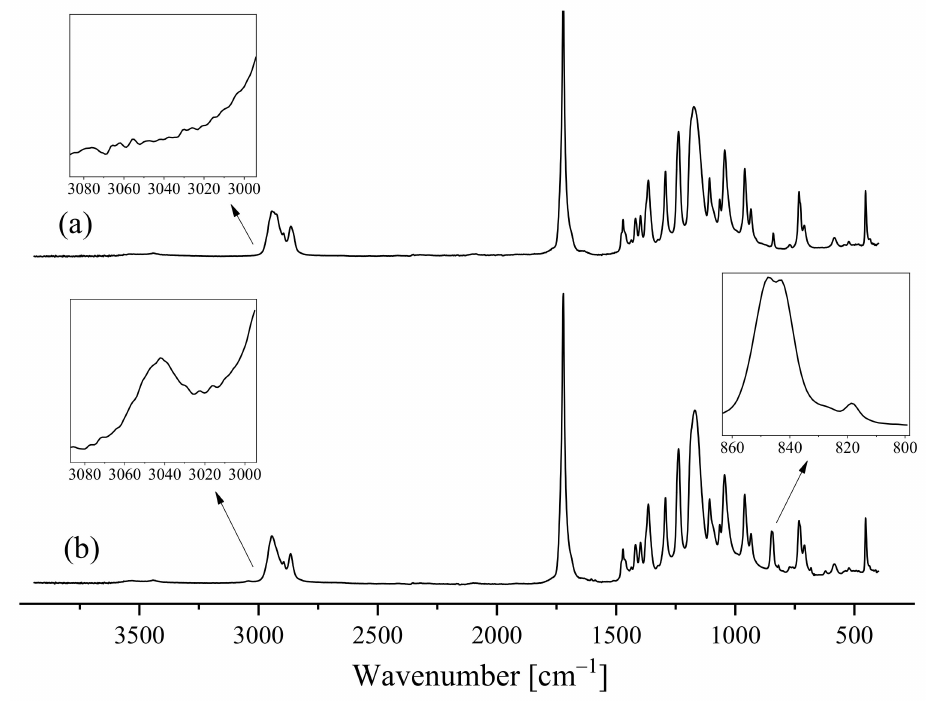
Figure 2. FT-IR spectra of Dod-PCL ( a ) and Pyr-PCL ( b